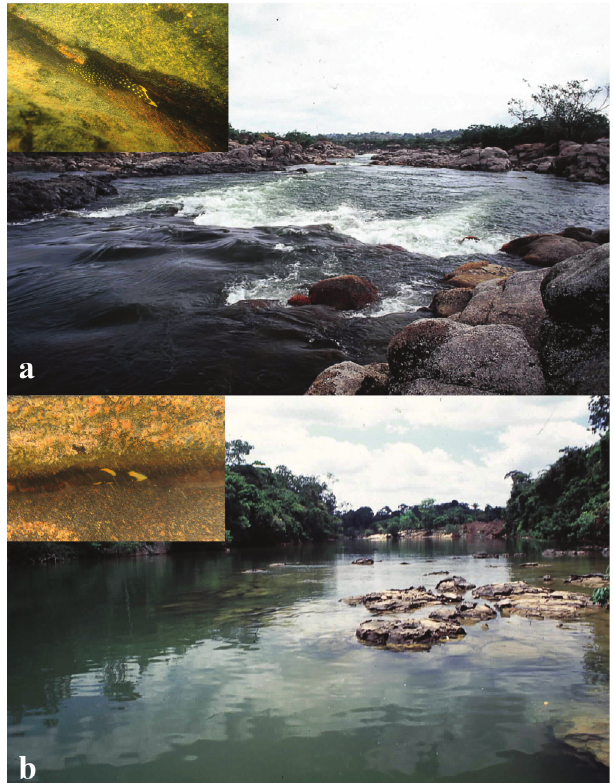
Fig. 4. Rio Xingu: (a) Cachoeira Buraco do Inferno, type locality of Baryancistrus xanthellus , and specimen hidden in crevice in detail and (b) Furo do Ramiro, type locality of B . chrysolomus , and specimen hidden in crevice in detail (underwater photos Henrique